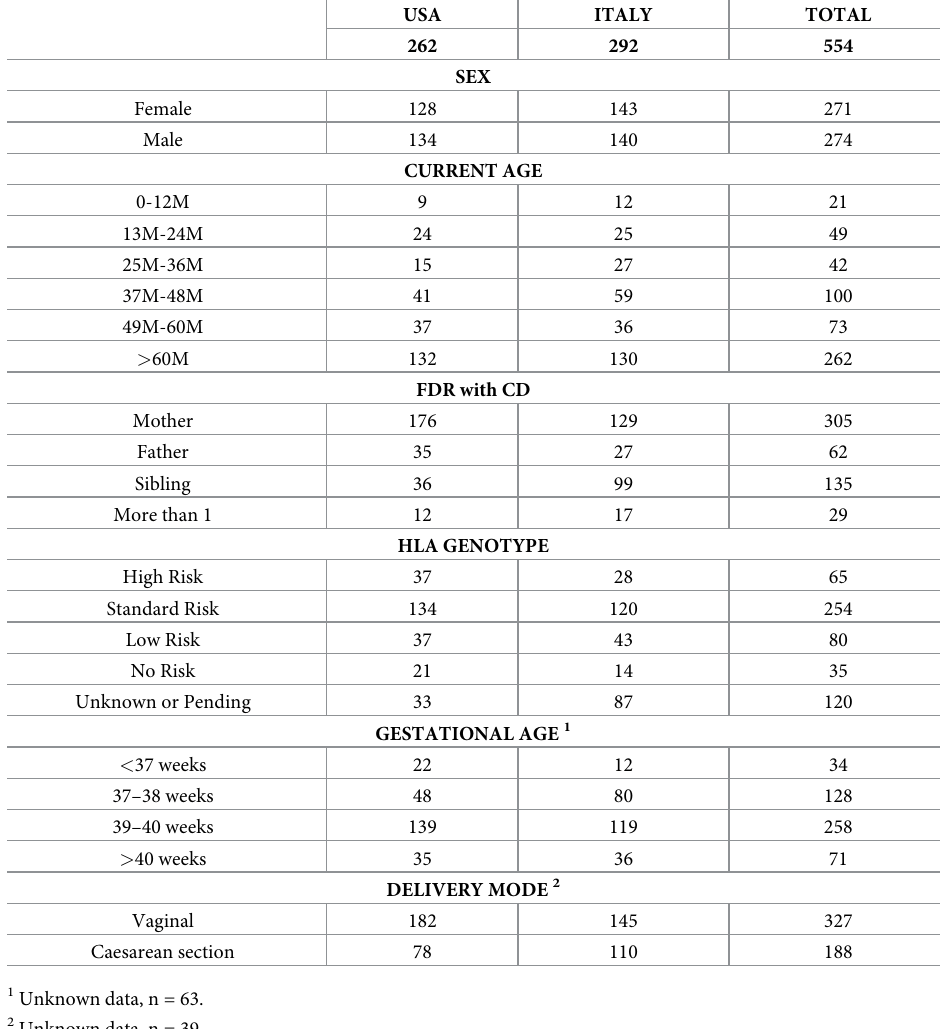
Table 2. CDGEMM subject demographic